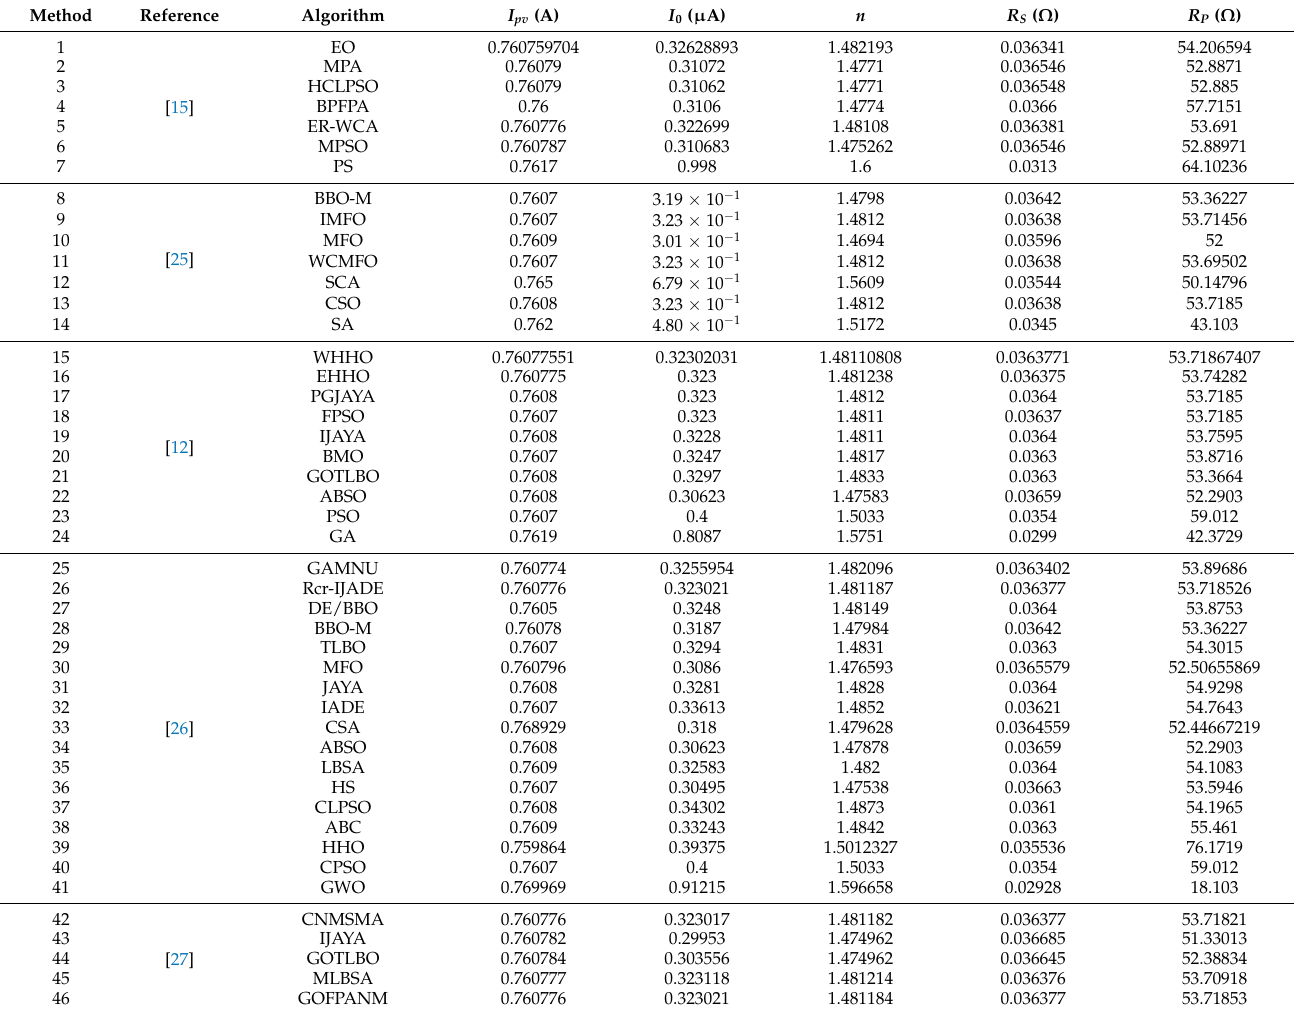
Table A1. Parameters values of the RTC France solar